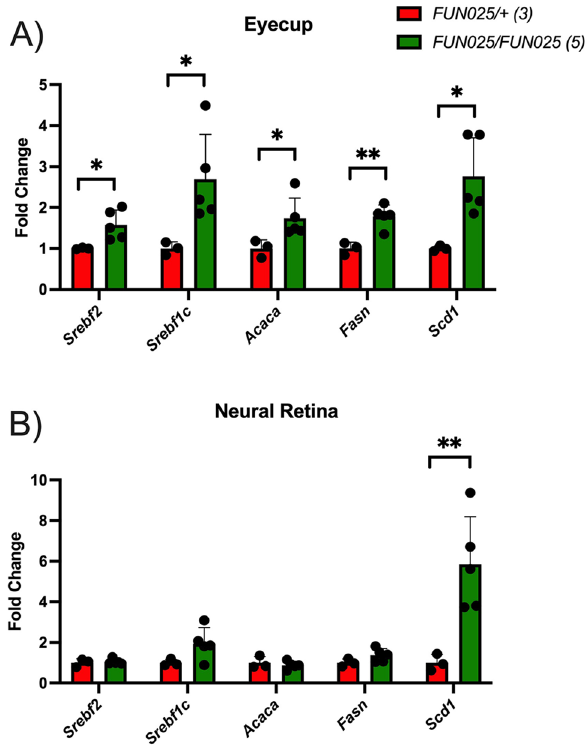
Figure 6. Lipid Metabolic Gene Expression in Eyecup and Neural Retinas of 2.5-month-old Heterozygous and Homozygous Tmem135 Mutant Mice. Quantitative PCR analysis of lipid metabolic transcription factors ( Srebf2 and Srebf1c ) and lipid synthesis genes ( Acaca , Fasn , and Scd1 ) in the ( A ) eyecups and ( B ) neural retinas of 2.5-month-old male Tmem135 FUN025 / + ( FUN025/ + ) and Tmem135 FUN025/FUN025 ( FUN025/FUN025 ) mice. Numbers in brackets denote number of mice used in experiment. Each dot represents each individual sample. * and ** indicates a P < 0.05 and P < 0.01 significance by Student’s T-test.